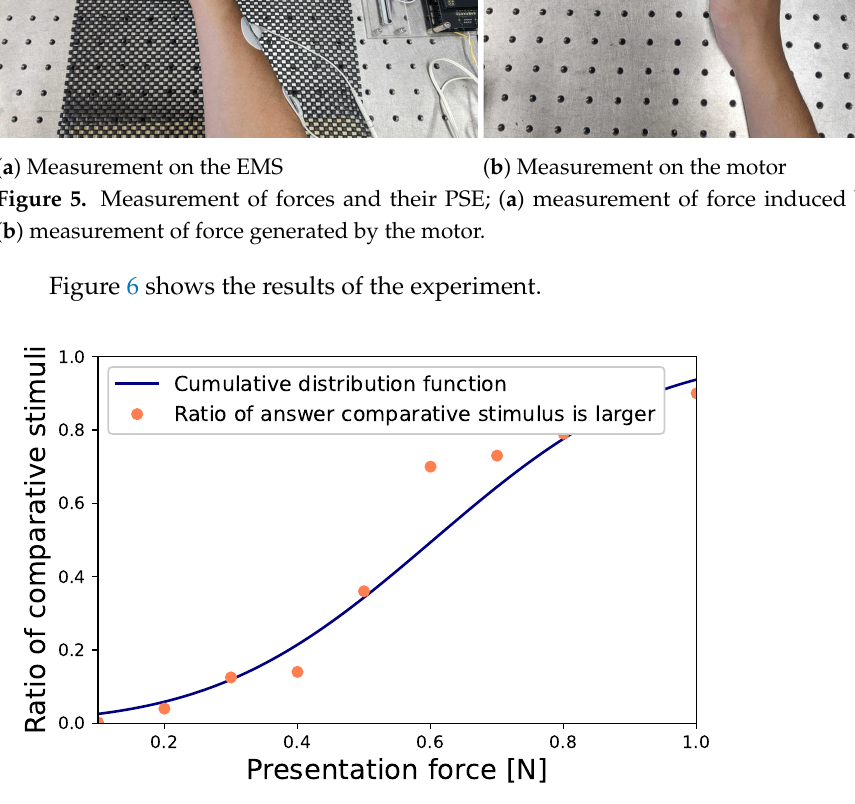
Figure 6. PSE between the force induced by the EMS and the